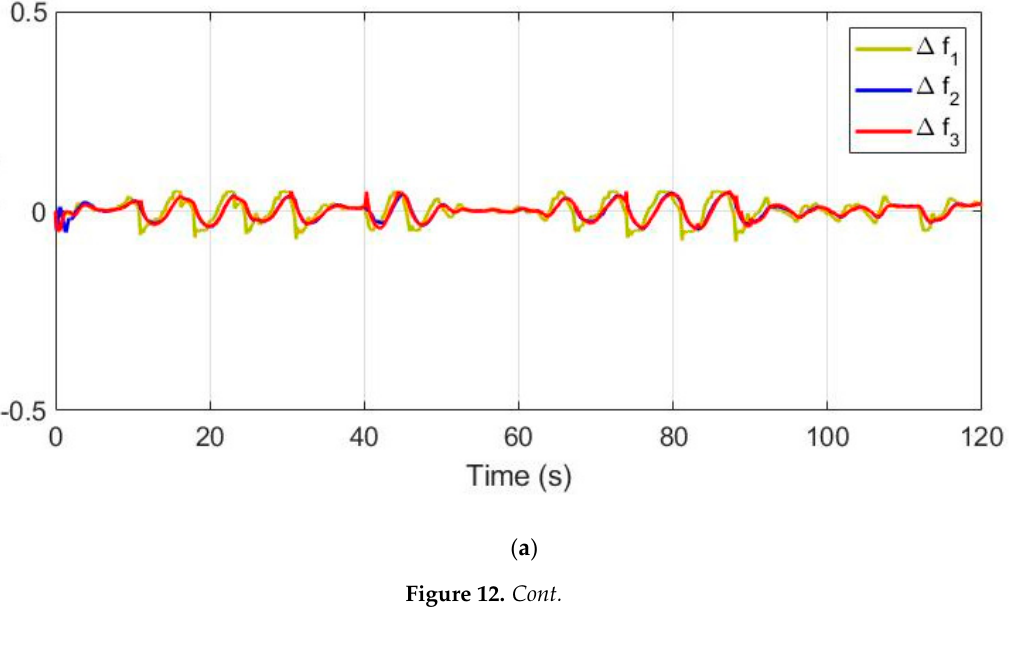
Figure 11. Case 3: ( a ) frequencies ( ∆ f i ), ( b ) voltages ( ∆ u i ), and ( c ) ∆ P tij responses.